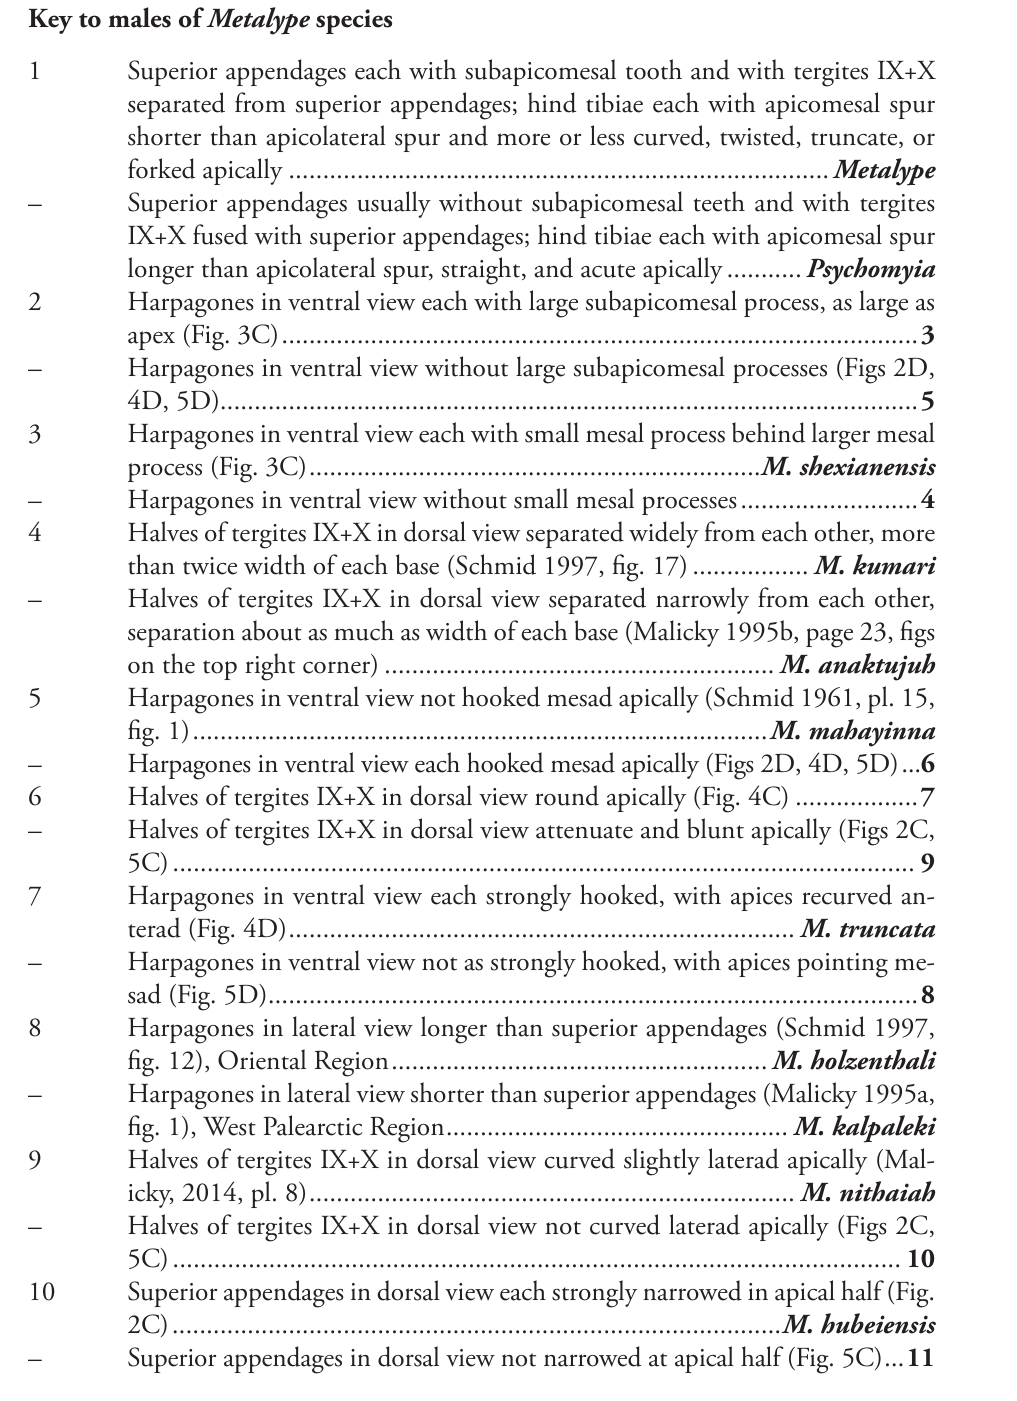
Superior appendages each with subapicomesal tooth and with tergites IX+X separated from superior appendages; hind tibiae each with apicomesal spur shorter than apicolateral spur and more or less curved, twisted, truncate, or forked apically ............................................................................... Metalype IX+X fused with superior appendages; hind tibiae each with apicomesal spur